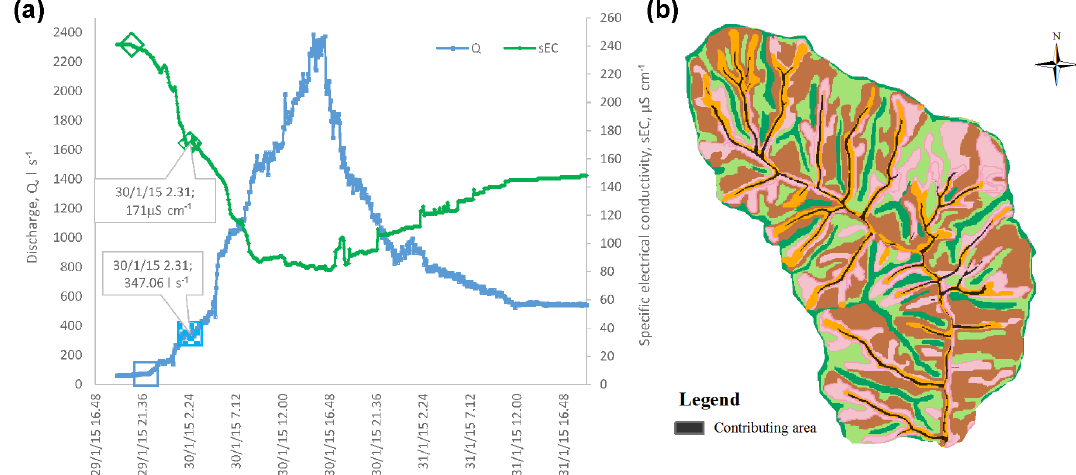
Figure 10. Initial hydro-chemograph conditions just after the beginning of the storm event, with approximately Q = 350Ls − 1 , filled blue square, and approximately EC = 170µS − 1 , filled green diamond, (b) scenarios corresponding to increasing groundwater ridging and initial saturation excess contributions to streamflow. The first occurs along the riparian corridor, and the second at the apical transient channels just downstream from the colluvial hollows, respectively.